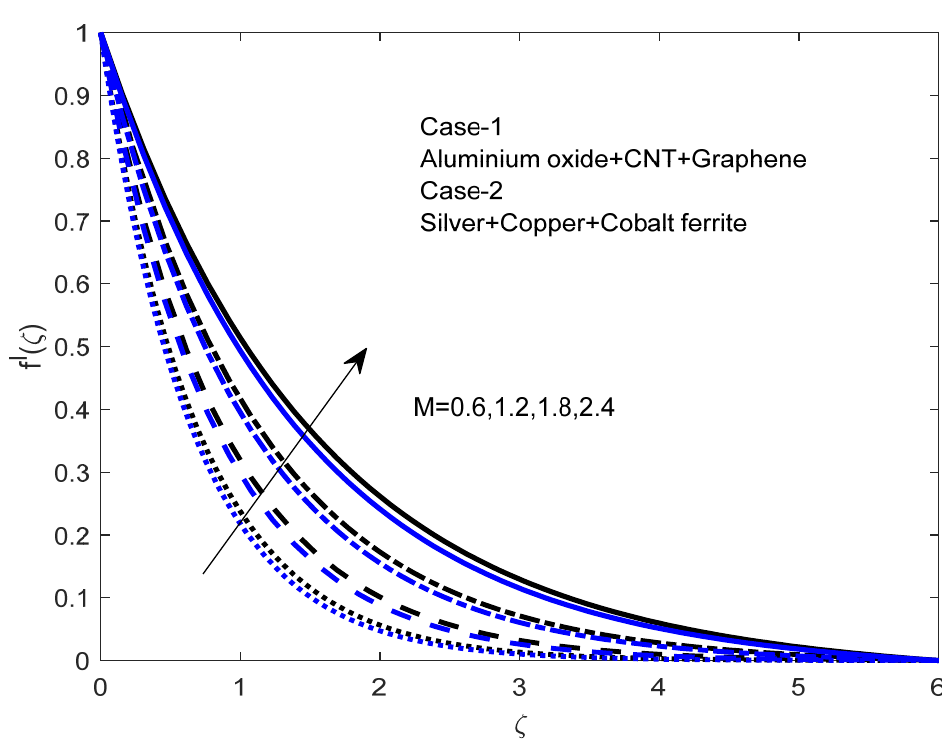
Figure 3. The effect of M on the velocity profile.